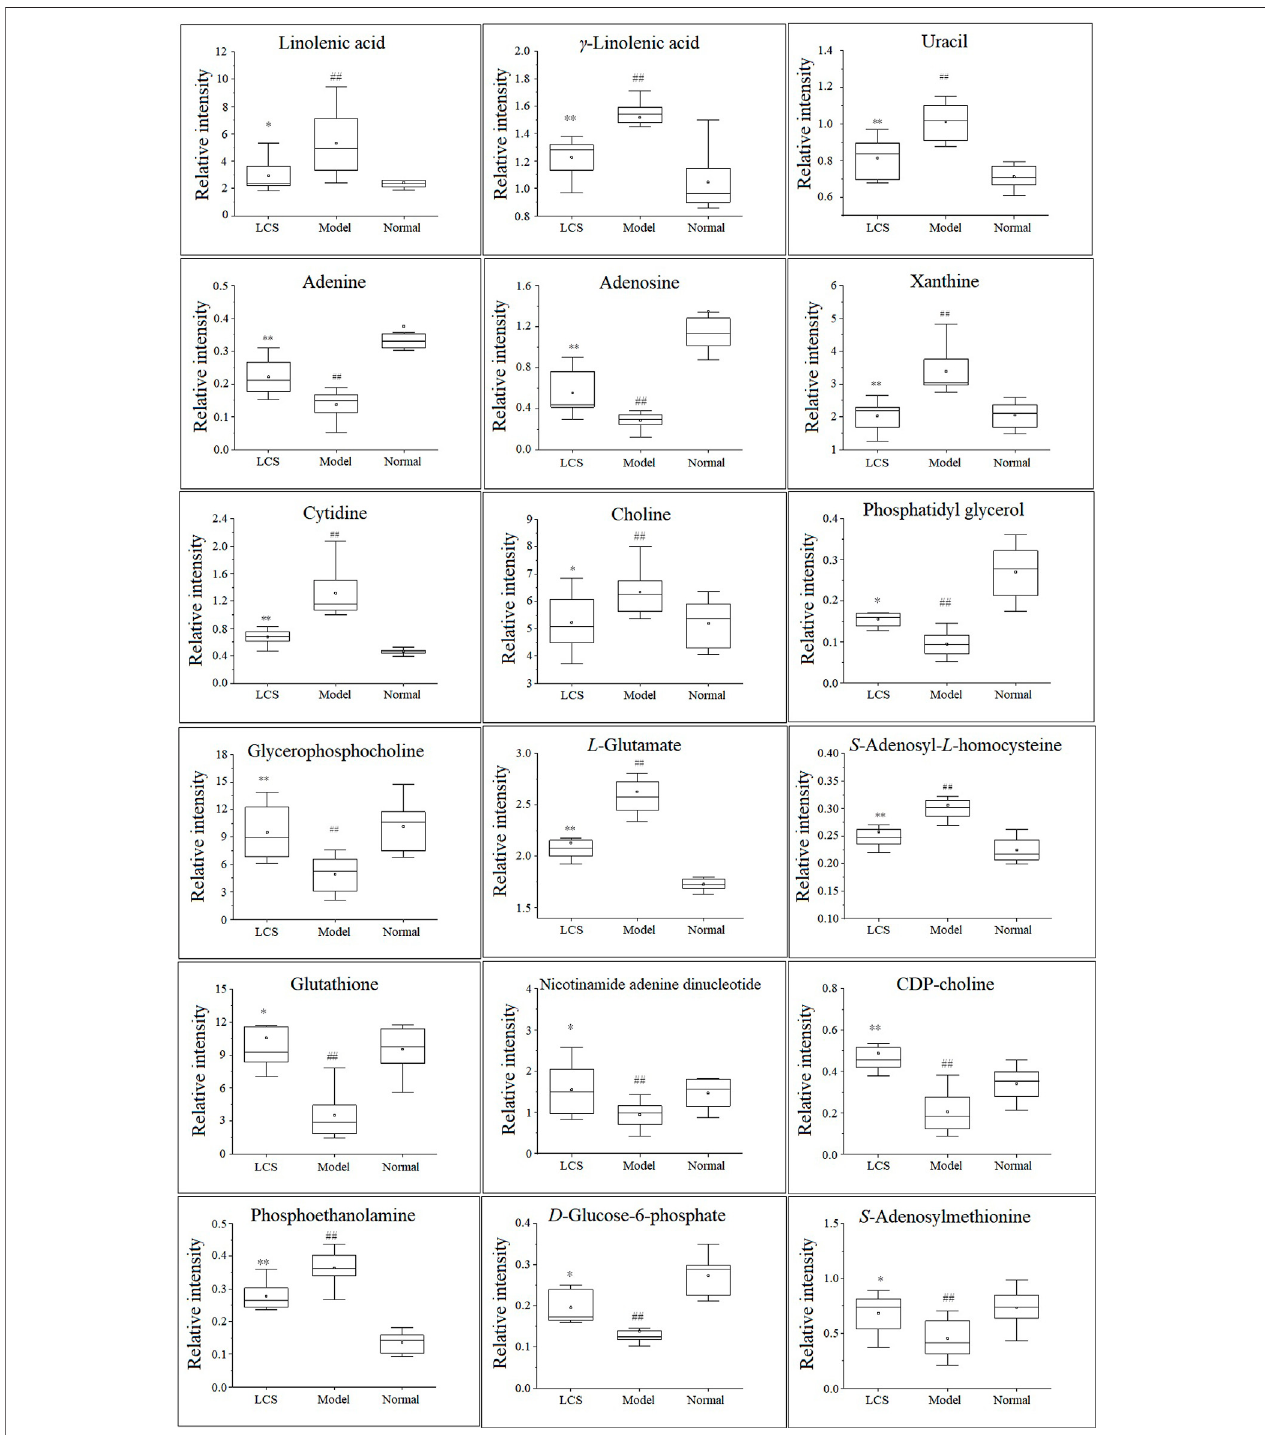
FIGURE 9 | Eighteen hepatic biomarkers reversed by LCS treatment. Note: ## p < 0.01 compared with the normal control group; ** p < 0.01, * p < 0.05 compared with the model group.